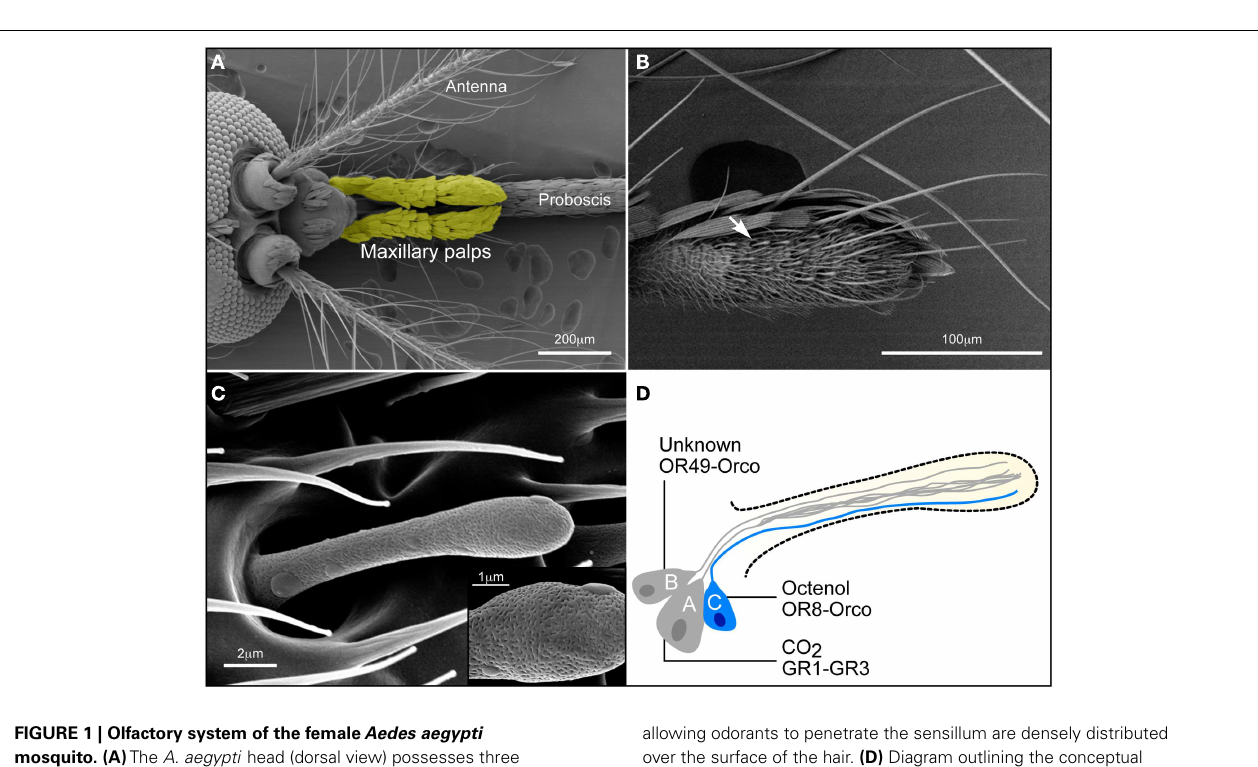
FIGURE 1 | Olfactory system of the female Aedes aegypti mosquito. (A) The A. aegypti head (dorsal view) possesses three olfactory appendages: the antennae, the maxillary palps (here colored yellow using Adobe Photoshop), and the proboscis. (B) Basiconic sensilla (white arrow) are the only chemosensory organs on the fourth segment of the maxillary palps (ventro-lateral view). (C) A basiconic sensillum is a club-shaped sensory organ. Pores (see insert)